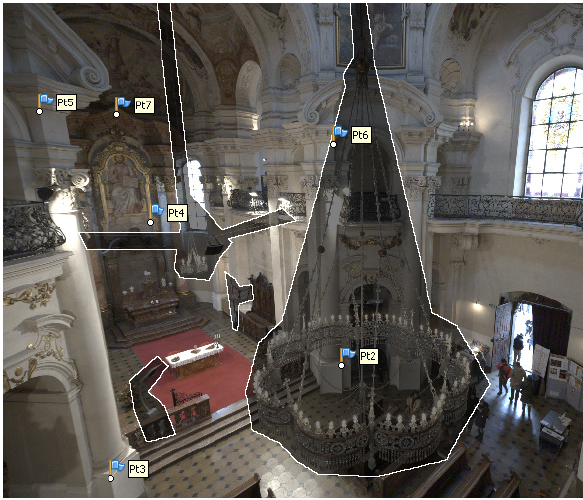
Figure 11. Masking of uninterested objects in